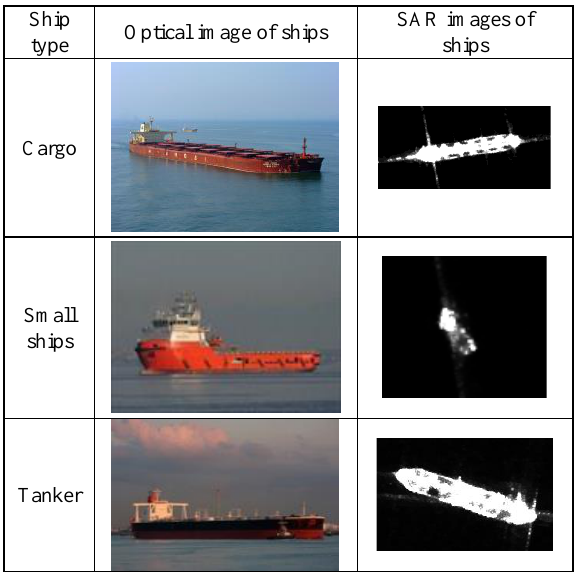
Table 1. Optical images of ships and their associated SAR